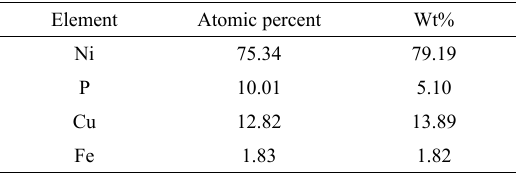
Table 8. The amount of different alloying element in Ni-P- 7gr/lit Cu composite coating. Element